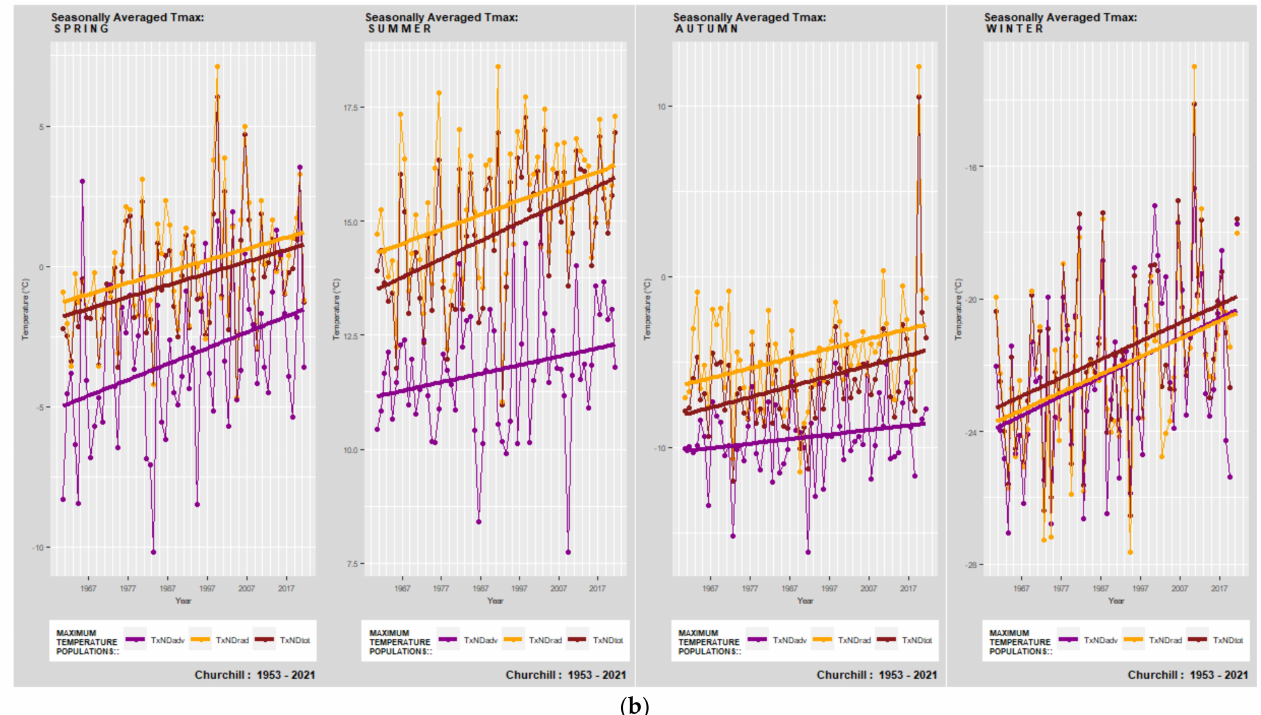
Figure 10. Northeastern Forest (NEF); Churchill (MB). Seasonally averaged daily temperature minima ( a ) and maxima ( b ), listed in order of Spring, Summer, Autumn, and Winter. ( a )—Total Temperature Minimum ( TT n ) (green), Radiative Temperature Minimum ( RT n ) (blue), and Advective Temperature Minimum ( TT n ) (pink); ( b )—Total Temperature Maximum ( TT x ) (brown), Radiative Temperature Maximum ( RT x ) (orange), and Advective Temperature Maximum ( TT x ) (purple).